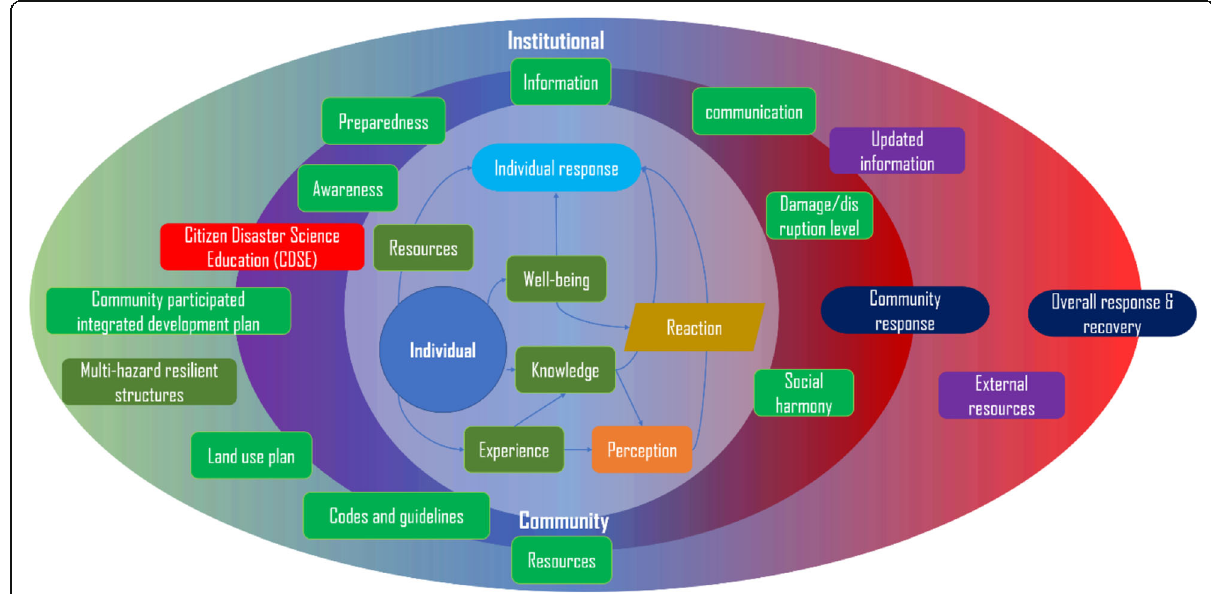
Fig. 1 Eye diagram of components of disaster risk reduction with individual, community and institutional level engagement for pre-disaster, during and post-disaster